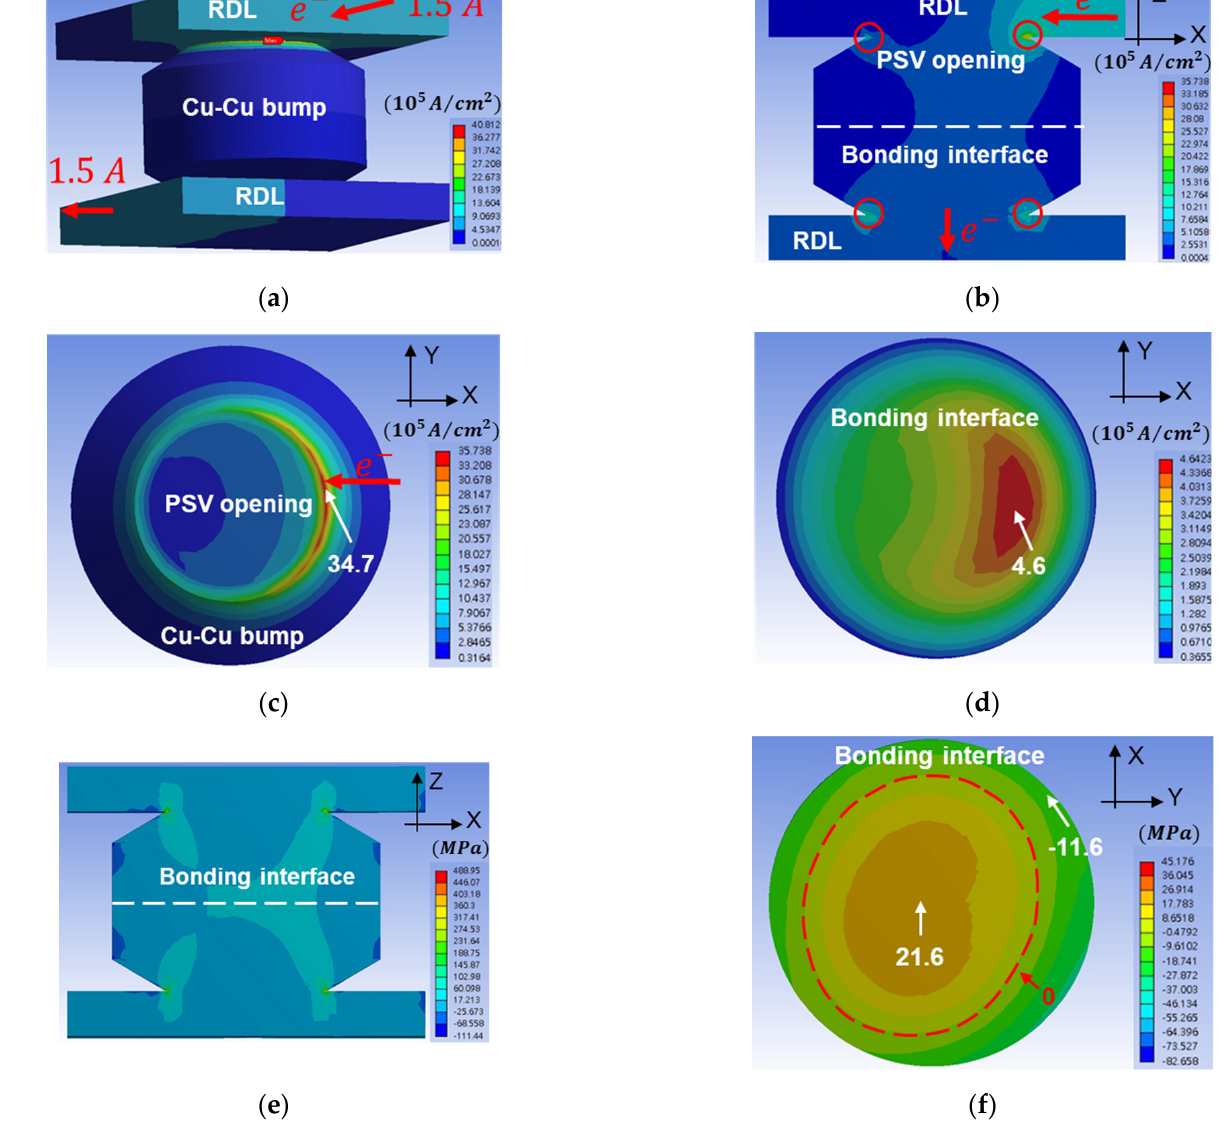
Figure 9. The FEA results of current density distribution and stress distribution. ( a ) The 3D model with electron current direction of single Cu–Cu bump. ( b ) The current density distribution of the cross-section of a Cu-Cu bond. Current crowding is found at the PSV opening, which is marked by red circles. ( c ) The current density distribution at the top die PSV opening. ( d ) The current density distribution at the bonding interface. The maximum current density is 4.6 × 10 5 A/cm 2 . ( e ) The distribution of stress along the z-axis at the cross-section of the Cu–Cu bump. ( f ) The distribution of stress along the z-axis at the bonding interface. The maximum tensile stress during the EM test at the bonding interface is 21.6